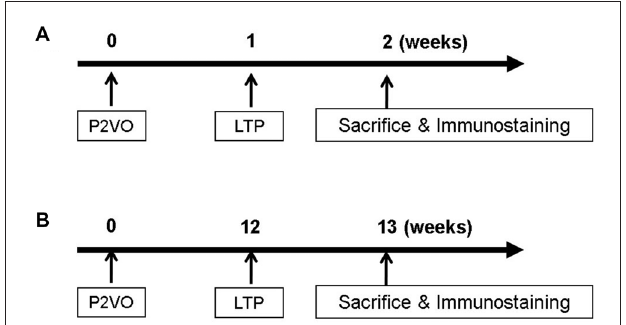
FIGURE 1 | In order to evaluate neurogenesis by long-term potentiation (LTP) induction in the hypoperfusion model, high frequency stimulation (HFS) was delivered into the hypoperfusion rats in the subacute phase (1 week after permanent 2-vessel occlusion, P2VO surgery; A ) or in the chronic phase (12 weeks after P2VO surgery; B